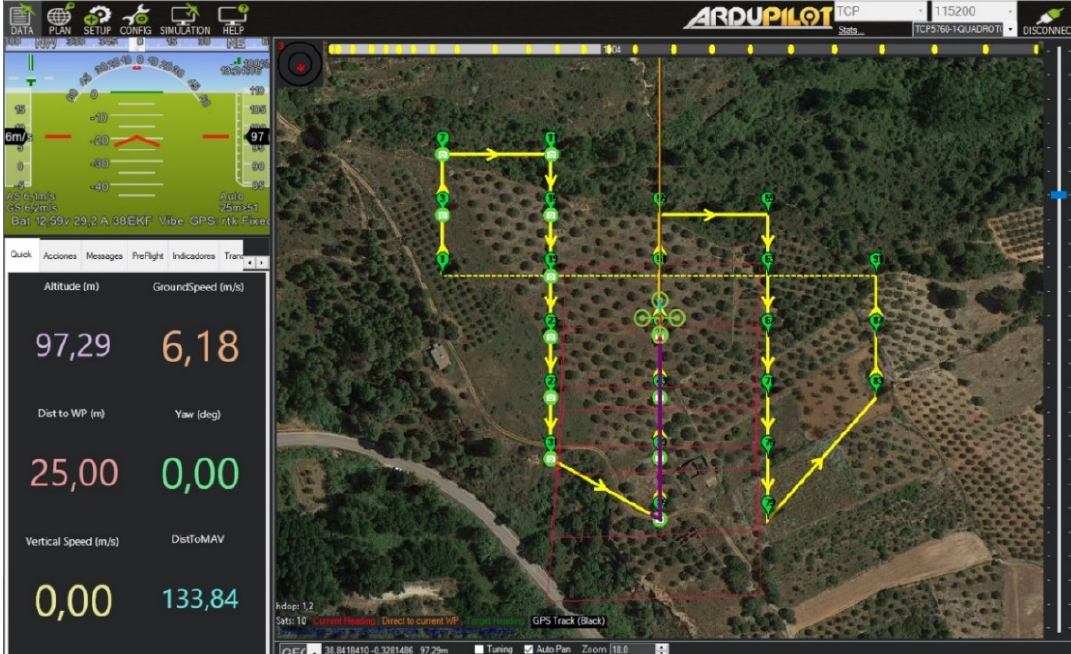
Figure 15. Mission-Planner and SITL environment.